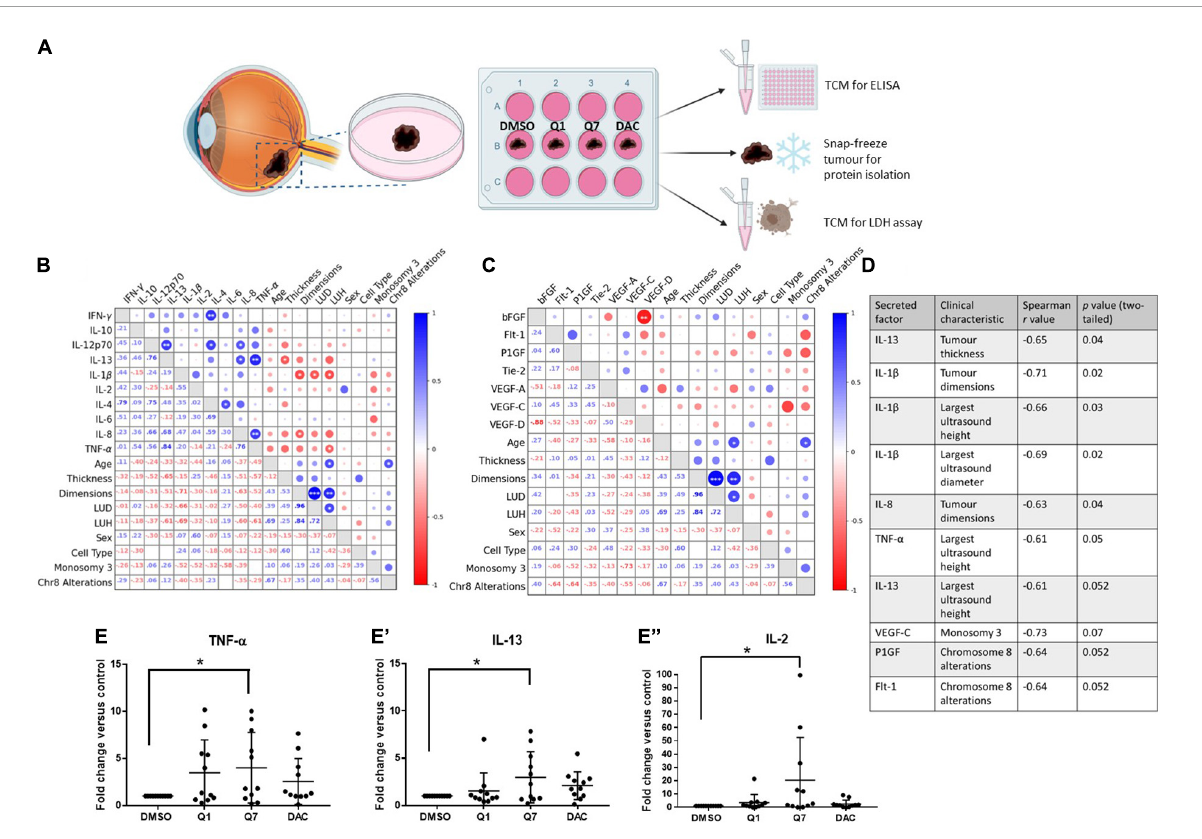
FIGURE3 1,4-dihydroxy quininib significantly increases the secretion of IL-13, IL-2, and TNF- α in primary UM tumour explants vs. vehicle control. (A) Schematic of the explant culture protocol to compare drug effects. Each primary UM tumour was dissected into 4 fragments and grown in complete media with 20 µ M quininib (Q1), 20 µ M 1,4-dihydroxy quininib (Q7), 20 µ M dacarbazine (DAC) or vehicle (DMSO) for 72 h, based on previously optimized explant culture experiments (29), before collection of the TCM. TCM was analyzed by ELISA, to detect the secretion